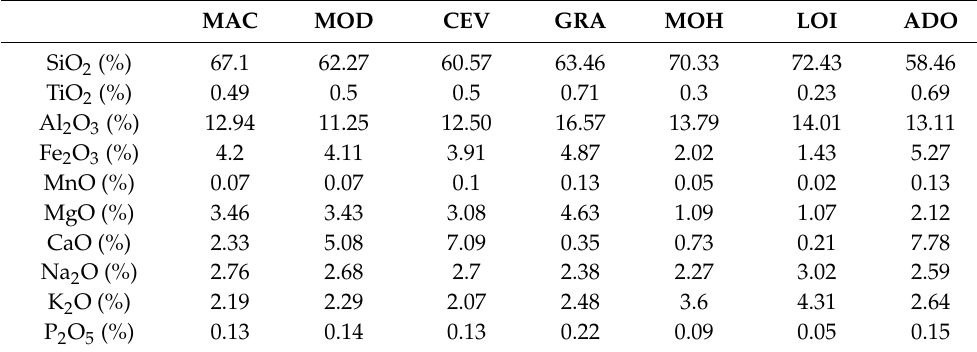
Table A1. Mean chemical composition of the sandstone formations according to Dinelli et al. [68], van de Kamp and Leake [69], and Gazzi